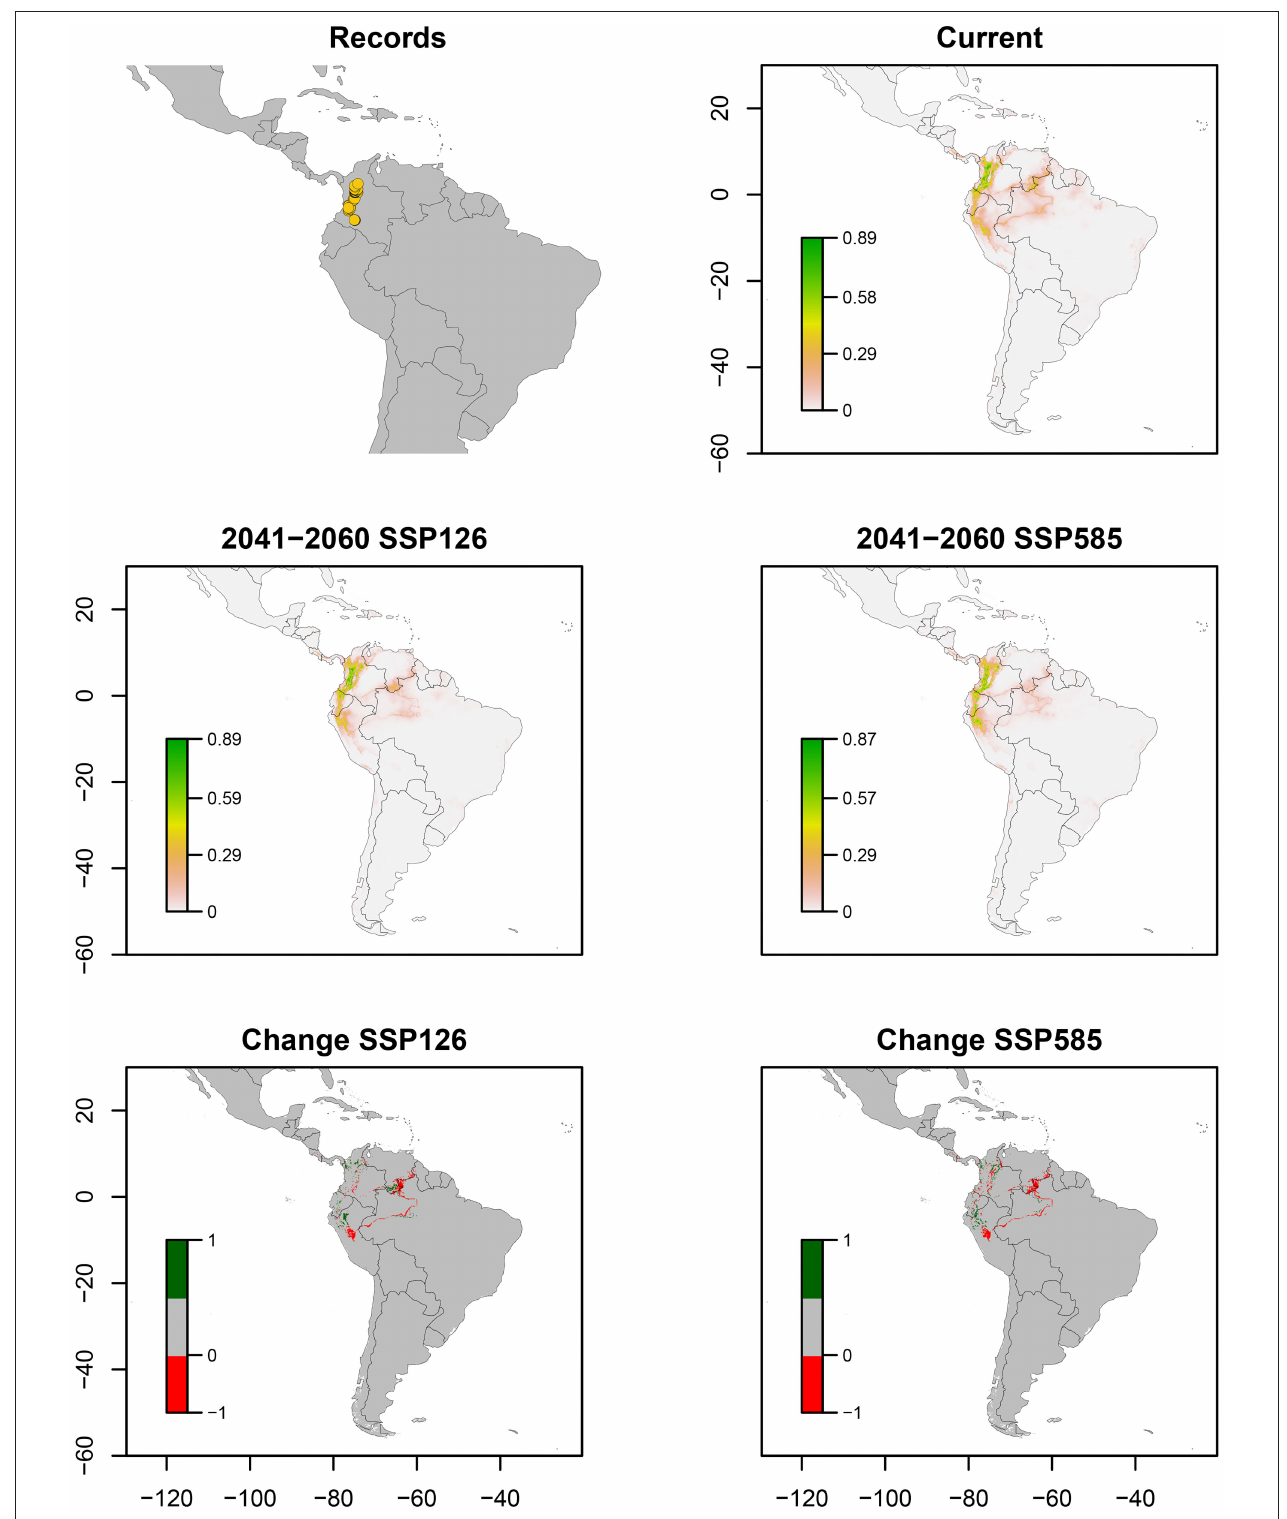
FIGURE 5 | Ecological niche models of Zulia carbonaria. Distribution records, current potential distribution, future potential distribution (2041–2060) under SSP126 and SSP585 scenarios, and comparison between current and future scenarios (change SSP126 and SSP585). The scale shows the habitat suitability being 1 = higher suitability. Scale in change maps − 1 = possible extinction and 1 = possible